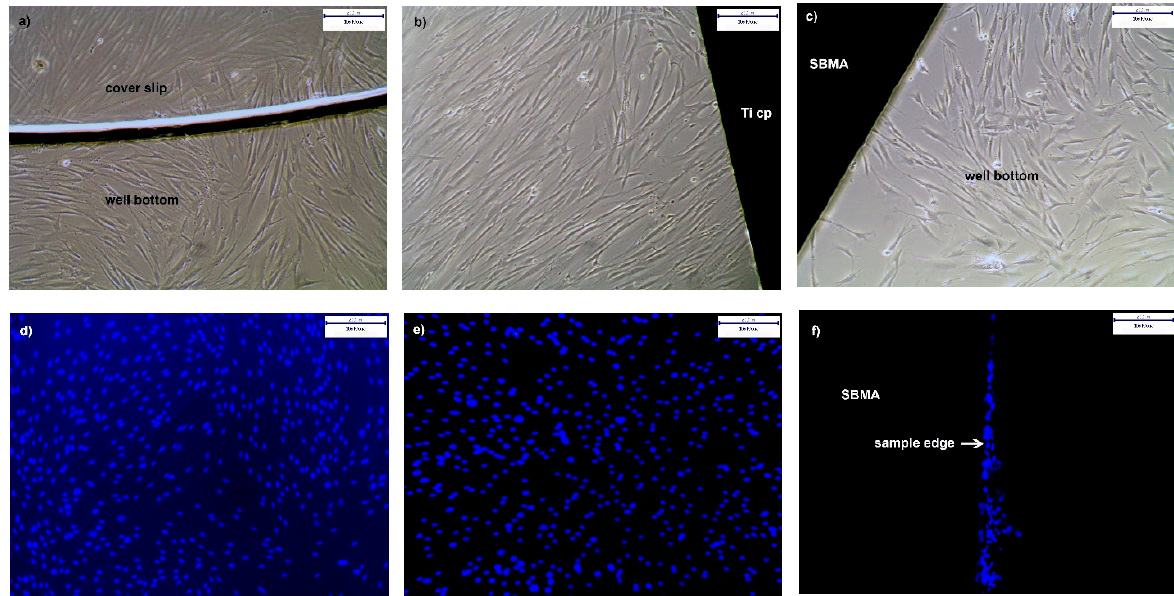
Figure 7. hgF in direct contact with samples. ( a – c ) Bright field and ( d – f ) fluorescence micrographs of hgF seeded in the wells containing coverslips ( a , d ), as-received TiCP ( b , e ), and polySBMA coatings ( c , f ) after 72 h of incubation. Notice the tiny string of hgF that adheres solely to the edge of the polySBMA-coated sample (arrow in ( f )).